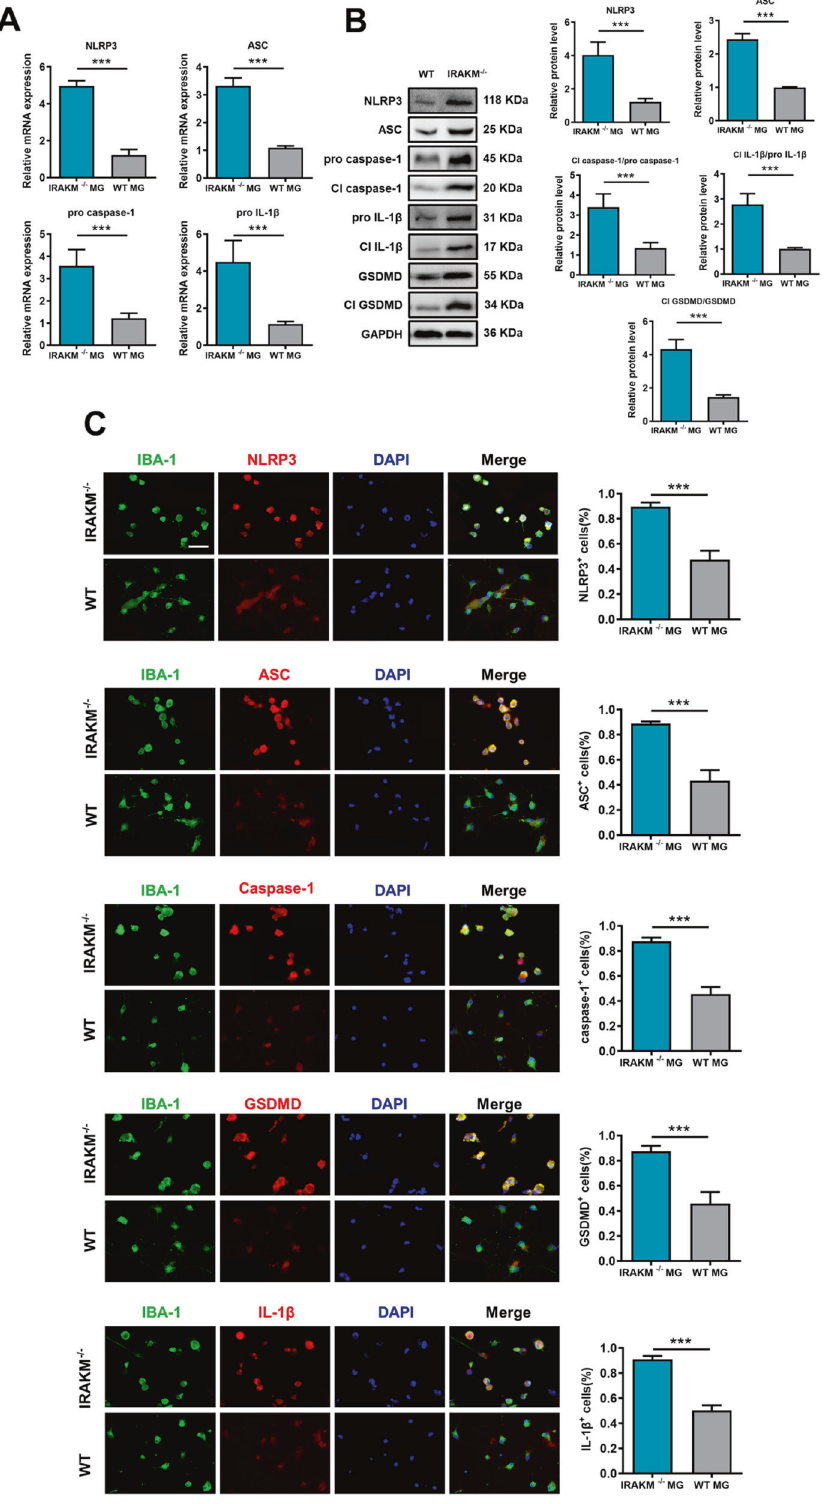
Fig. 6 Microglia-speci fi c IRAK-M ablation aggravates NLRP3 in fl ammasome-related activity and GSDMD-mediated pyroptosis in vitro. Stimulation of 100 ng/mL LPS for 3.5 h followed by 2.5 μ M nigericin for 1 h was performed to mimic EAE pyroptosis in primary microglia. A Whole-cell lysate was collected for RT-PCR. The mRNA levels of NLRP3, ASC, cleaved caspase-1, cleaved GSDMD, and cleave IL-1 β are presented as relative expression compared to WT microglia (MG) ( n = 5 per group). B Western blotting of microglial protein levels of NLRP3, ASC, full-length (FL) and cleaved caspase-1, IL-1 β , and GSDMD. The corresponding charts show the quanti fi cation of target protein expression ( n = 4 per group). C Representative immuno fl uorescent analysis of NLRP3, ASC, caspase-1, IL-1 β , and GSDMD in microglia. Scale bar: 20 μ m. The percentage of NLRP3 + , ASC + , IL-1 β + , caspase-1 + , and GSDMD + microglia counted from ~160 microglia of fi ve independent cultures. Unpaired t -tests or the Mann – Whitney U test were applied, and data are shown as the mean ± SEM. *** P < 0.001. Cell Death and Disease (2023)